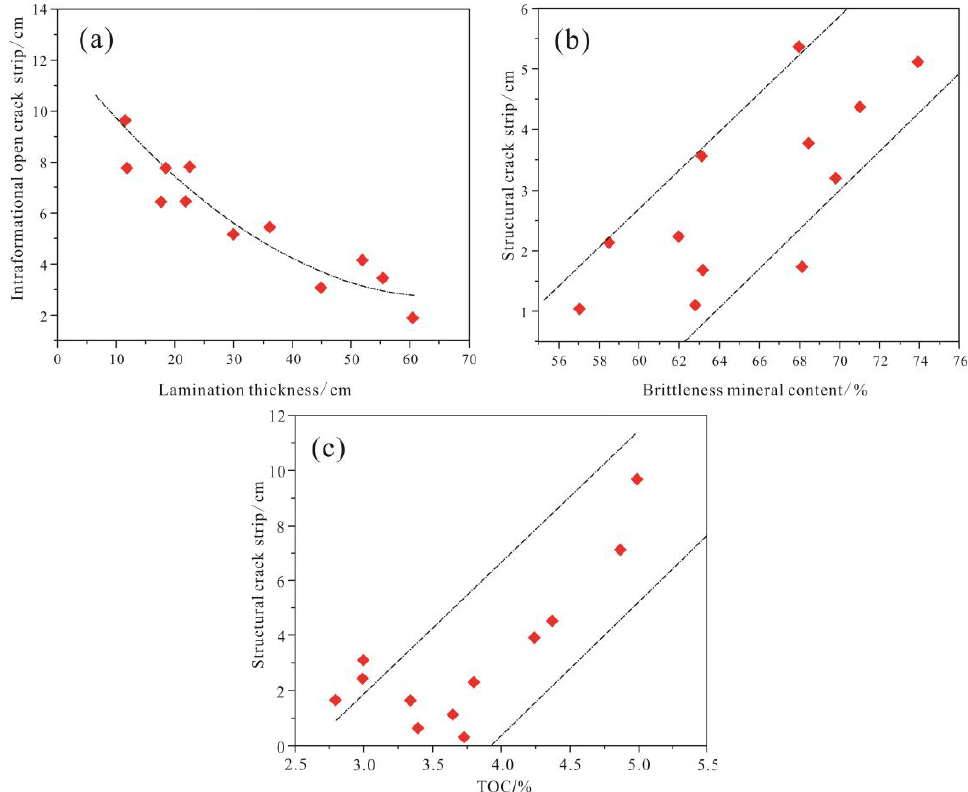
Figure 9. Crossplot of the crack line density and control factors in the Luzhou area. ( a ) Relationship between the tensile crack density and shale thickness; ( b ) relationship between the crack density and brittle mineral content; ( c ) relationship between the crack density and organic content.